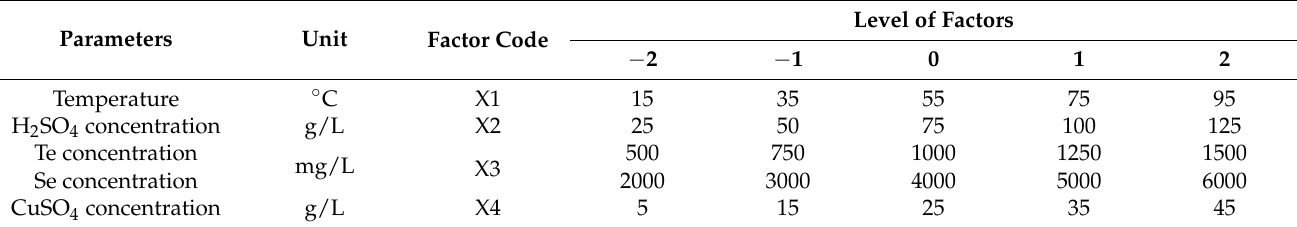
Table 2. The main factors and the corresponding levels.